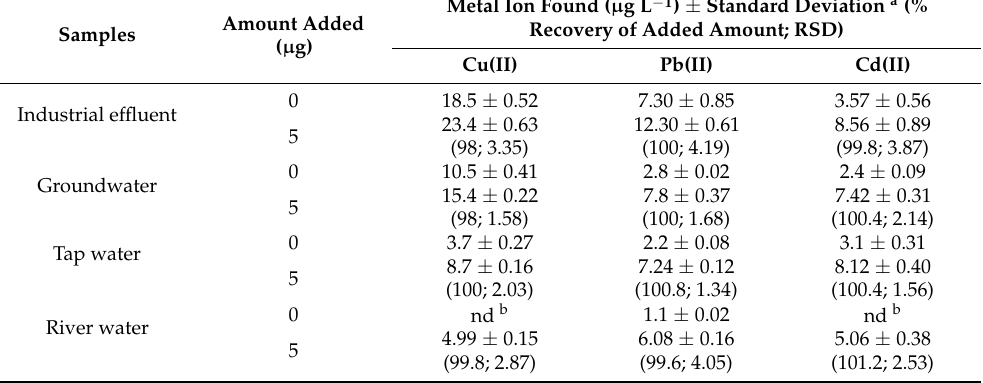
Table 5. Determination of metal ions in environmental water samples using ICP-OES after